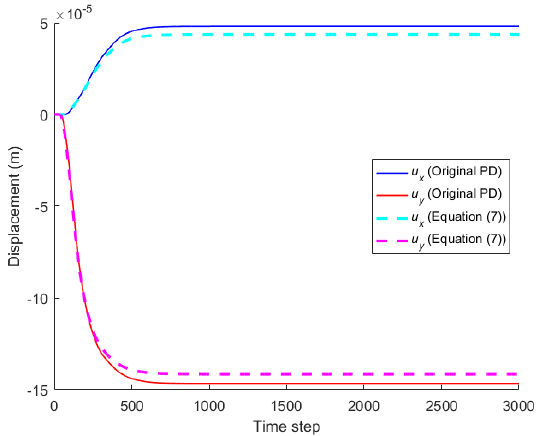
Figure 19. Convergence of displacement at x = − 0.125 m and y = − 0.125 m with time step.